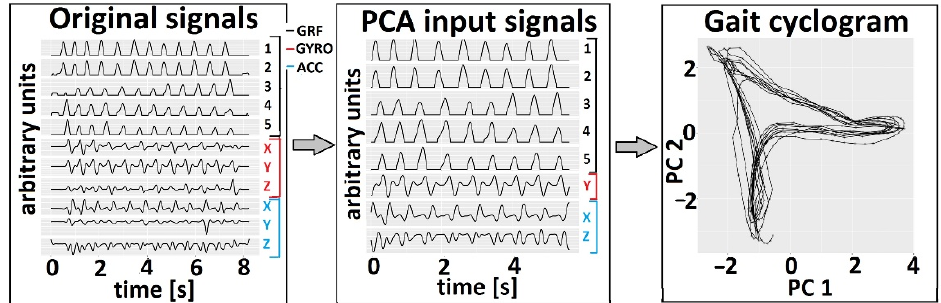
Figure 3. PCA cyclogram generation in the first two principal components space. Example data are from a person with no known sensory–motor impairment. The original signals were acquired by the Gait Teacher system ( left panel ). The subset of signals from the whole gait session ( middle panel ) was used to form a cyclogram (PC 2 vs. PC 1 , right panel ).